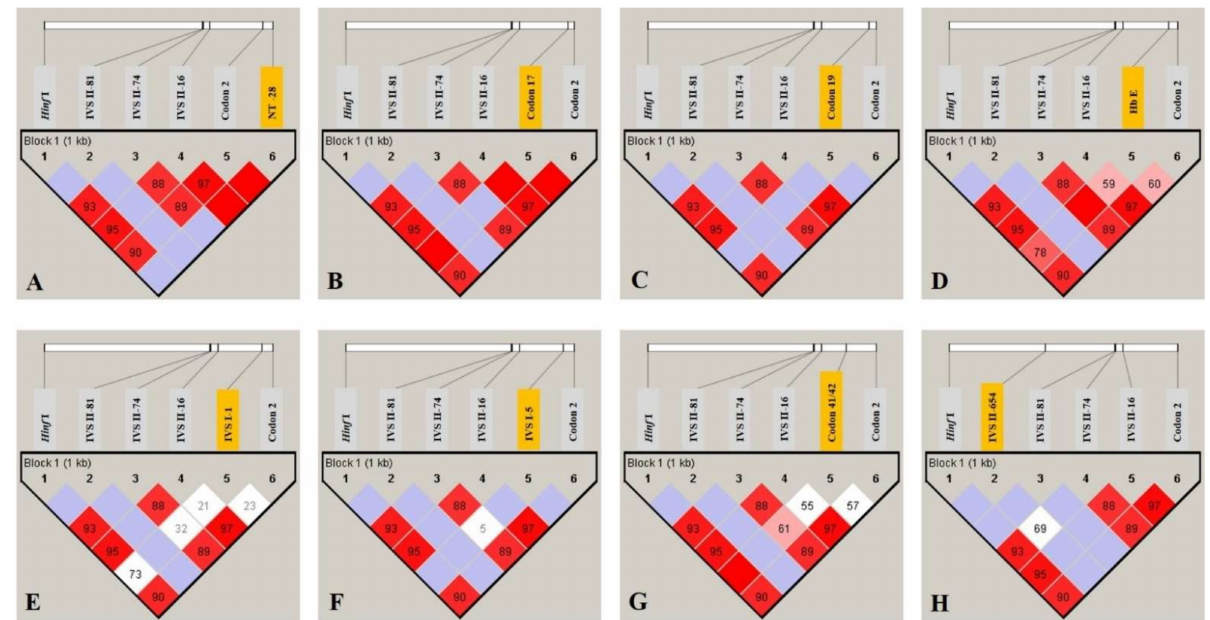
Figure 1. Pairwise analysis of linkage disequilibrium (LD) between five SNPs and each β -thalassemia mutation in a pooled sample of 163 subjects (( A – H ); NT-28 (A > G), codon 17 (A > T), codon 19 (A > G), codon 26; HbE (G > A), IVS I-1 (G > C), IVS I-5 (G > C), codon 41/42 (-TTCT) and IVS II-654 (C > T), respectively). The different color in the haploview plot follows the standard color scheme for haploview: white, |D (cid:48) | < 1, LOD < 2; shades of pink, |D (cid:48) | < 1, LOD ≥ 2; blue, |D (cid:48) | = 1, LOD < 2; red, |D (cid:48) | = 1, LOD ≥ 2.